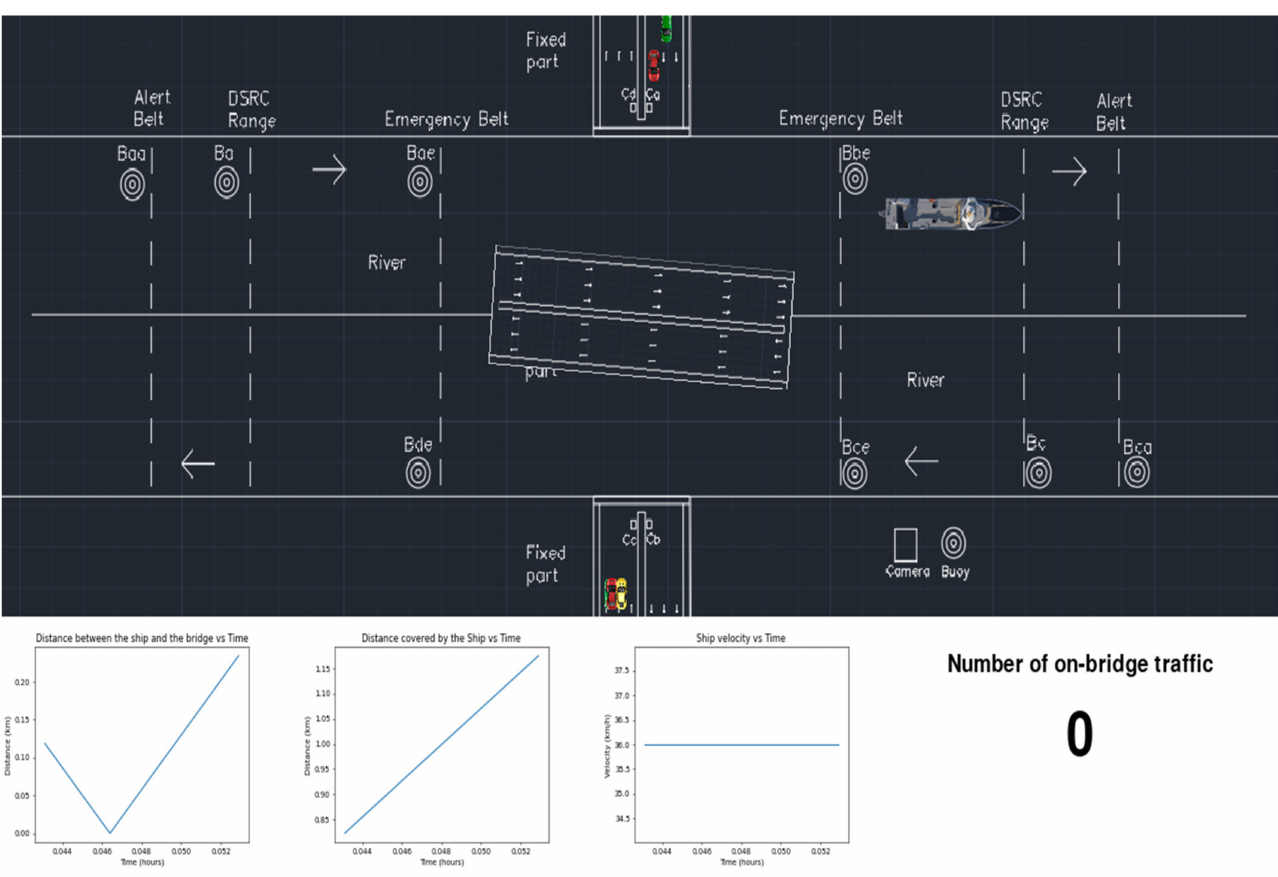
Figure 13. Movable bridge reformation